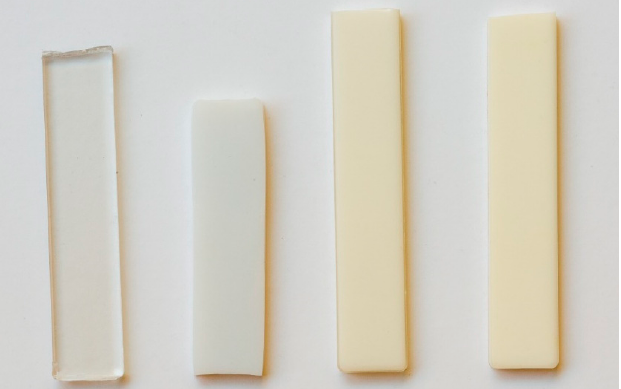
Figure 9 . From the left, transparent amorphous PET bar; PET bar after annealing at 150 °C for 30 min. It cold crystallises, turns white, but shrinks and warps; as-moulded 60/40 PBT/PET bar is turbid and has a yellow tint, and shows a transparent amorphous skin; after annealing 60/40 PBT/PET bar at 150 °C for 30 min, the skin cold crystallises, but unlike the amorphous PET, there is no major shrinkage or warpage. Table 5. Change in the length of the moulded bars (cut flexural bar) after annealing at 150 °C.